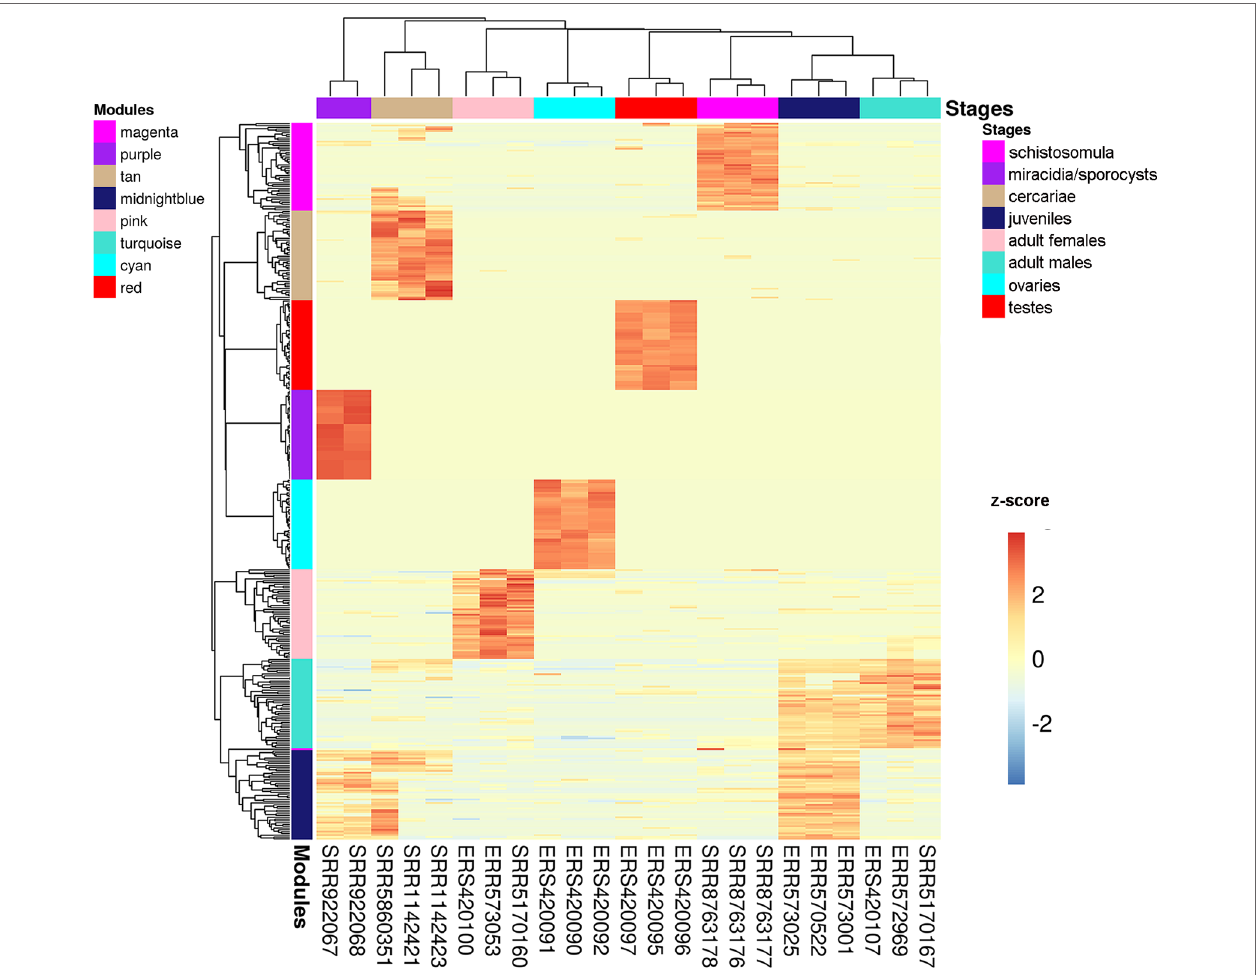
FIGURE 9 | Gene expression heatmap across the life-cycle stages/tissues of the parasite. Representative heatmap of gene expression levels for the top 50 genes (each in one line) with the highest GMM values from each of the eight modules (indicated at the left) with the highest positive correlation to each stage/tissue (indicated at the top). Expression data from three chosen RNA-seq libraries (one in each column) were picked as representative libraries for each stage/tissue, and their SRA or ENA accession numbers are given at the bottom; for miracidia/sporocysts only two RNA-seq libraries were available. Unsupervised clustering using the Euclidean distance was performed; expression of each gene (in one line) is shown as the z-score (from −3 to 3), which is the number of standard deviations above (red) or below (blue) the mean expression value of that gene across all RNA-seq libraries; the z-score color scale is shown on the